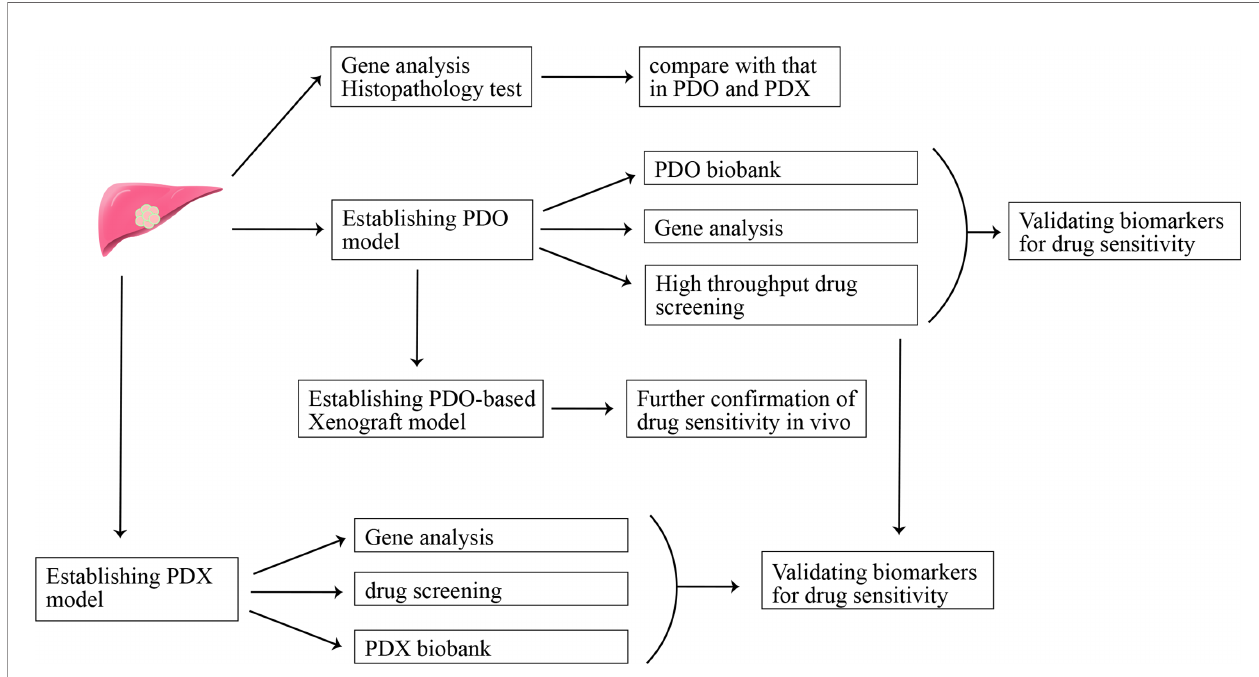
FIGURE 1 | Patient-derived organoid (PDO) model and patient-derived xenograft (PDX) model in precision